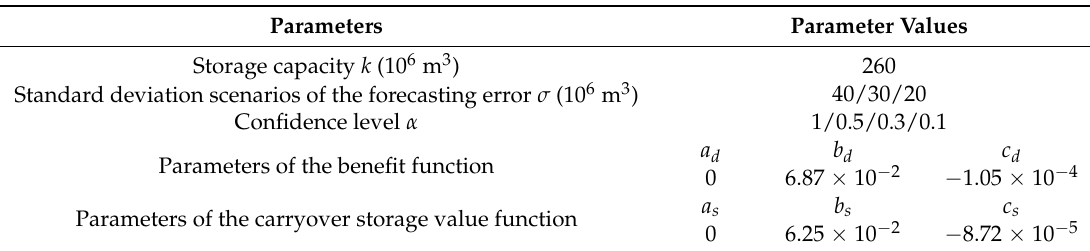
Table 1. Parameters of the case study.